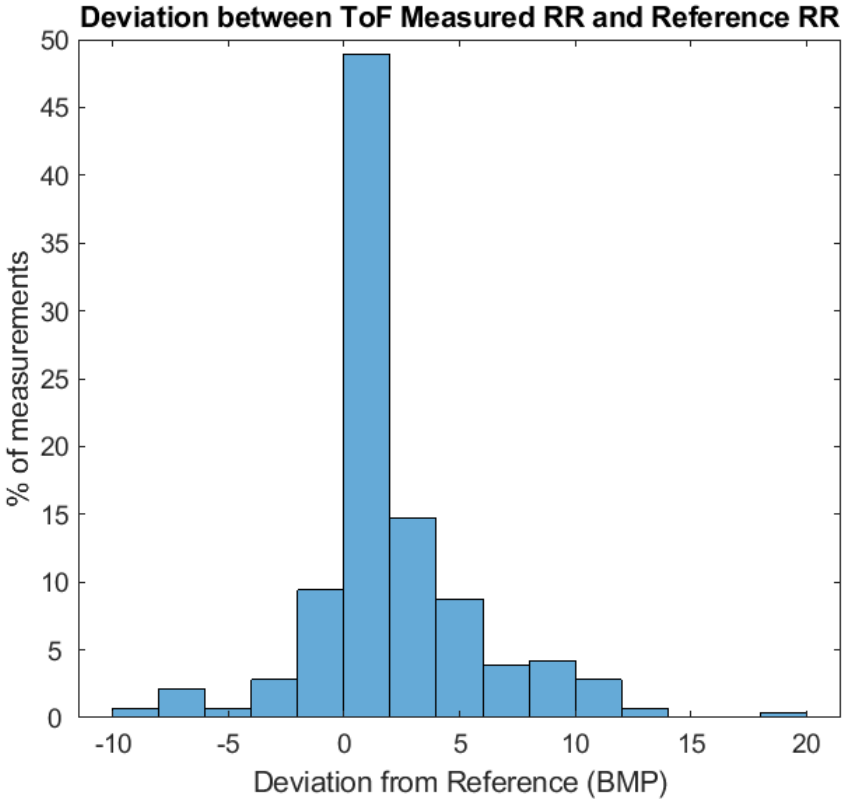
Figure 12. Percentage of ToF–based RR measurements versus deviation from reference